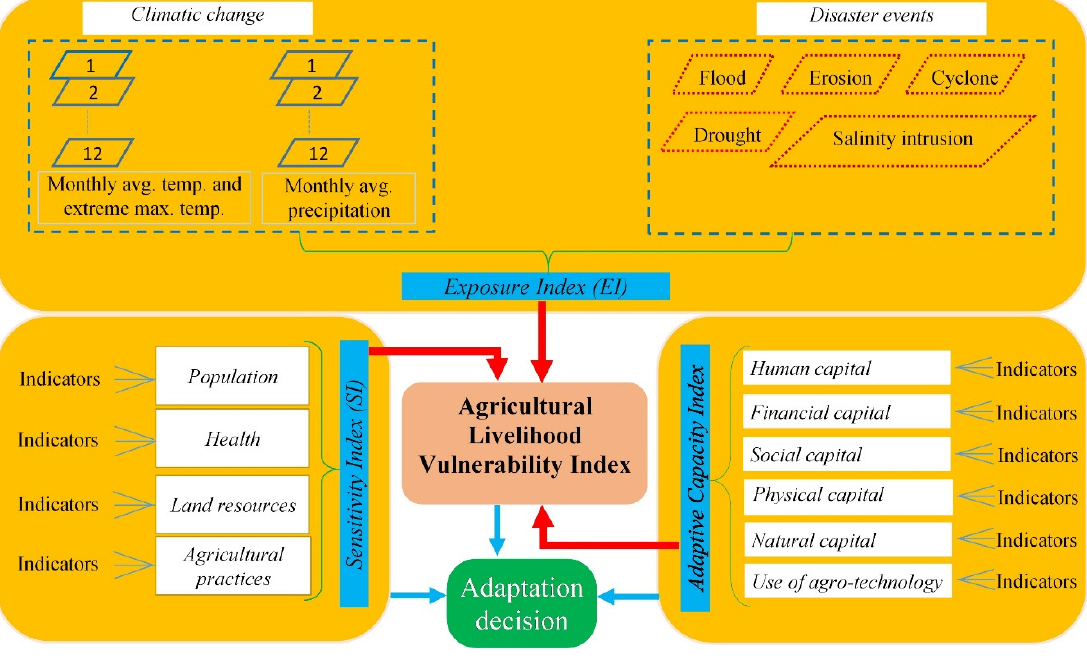
Figure 1. Framework of vulnerability assessment.